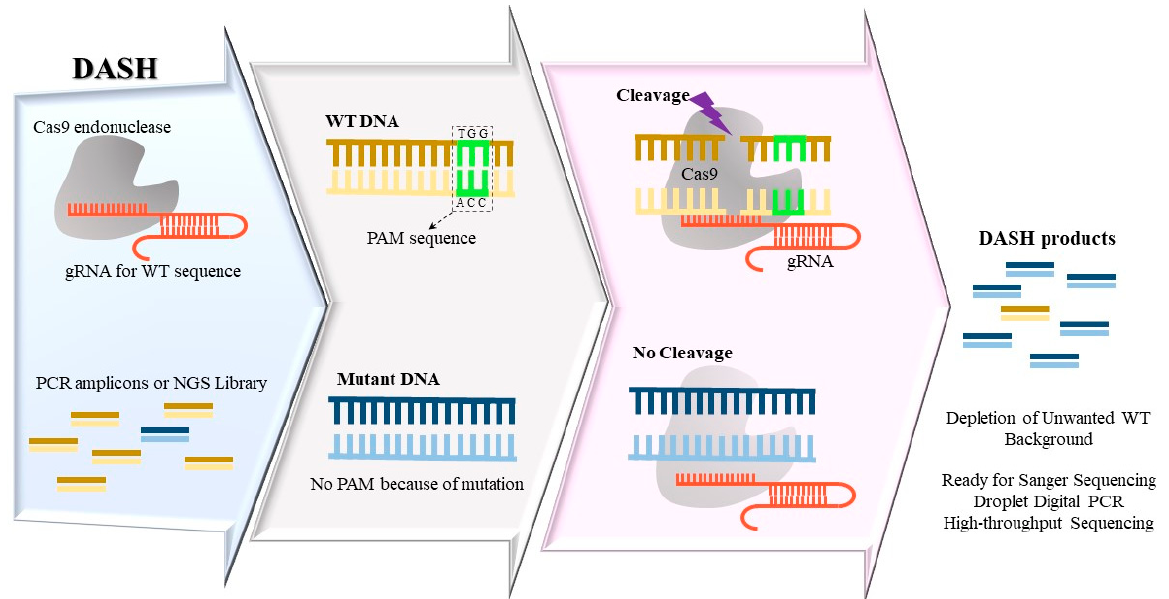
Figure 2. Depletion of Abundant Sequences by Hybridization (DASH) method removes excessive wide-type (WT) DNA in PCR amplicons using guide RNA (gRNA) against PAM-containing WT sequences, in conjunction with Cas9 enzyme. When a mutation alters the PAM sequence, the Cas9- gRNA complex cannot create a double-strand break efficiently, thus the intact mutant strands are amplified selectively and are detected via subsequent detection methods.